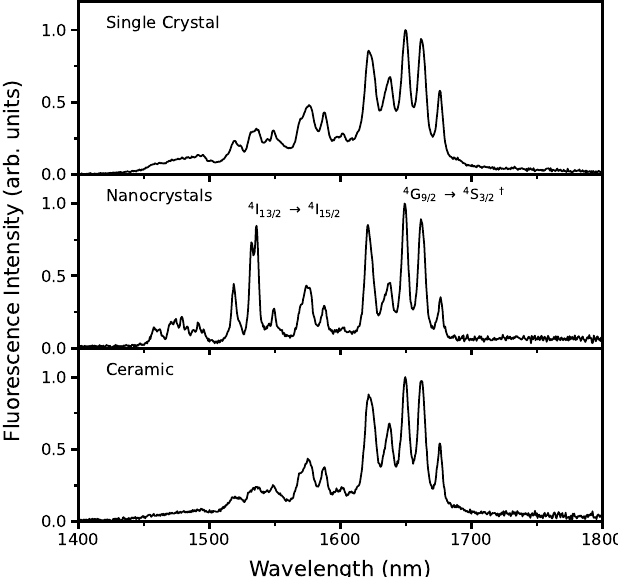
Figure 4. Normalized NIR fluorescence spectra of Er 3 + :YAG single-crystal, nanocrystal, and poly- crystalline ceramic at room temperature under 980 nm excitation. † Denotes transition used for lifetime